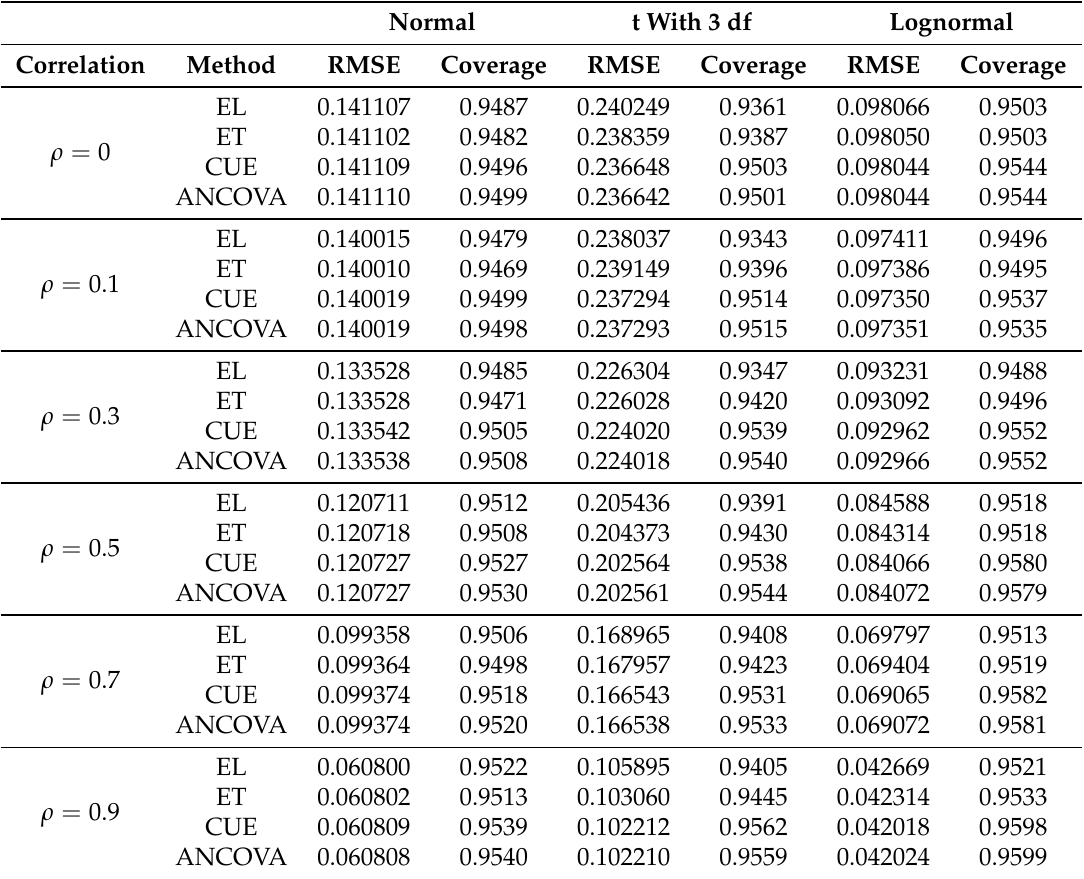
Table 2. Estimated root mean squared error and empirical coverage of nominal 95% confidence intervals (1